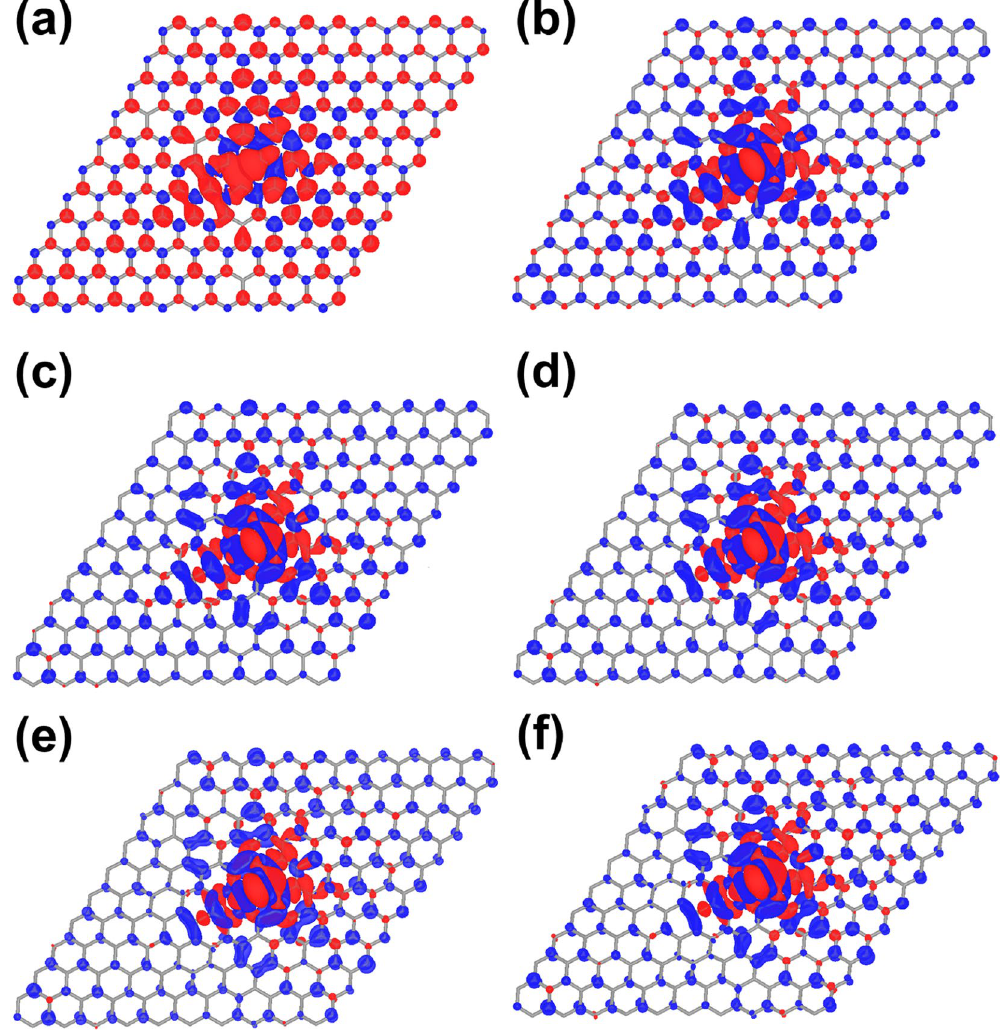
Figure 2. Evolution of spin density distribution of graphene with monovacancy in the 12 × 12 supercell. ( a )–( f ) at Δ θ = 0°–5°. Isosurfaces with values of ± 0.0001 e/bohr 3 are shown. The red and blue surfaces correspond to the densities of spin up and spin down states,